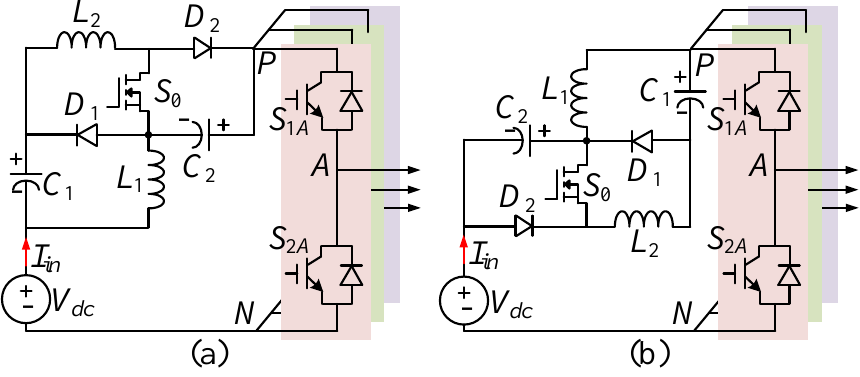
Figure 1. Topologies of ADC-qZSI: ( a ) Type 1 and ( b ) Type 2.